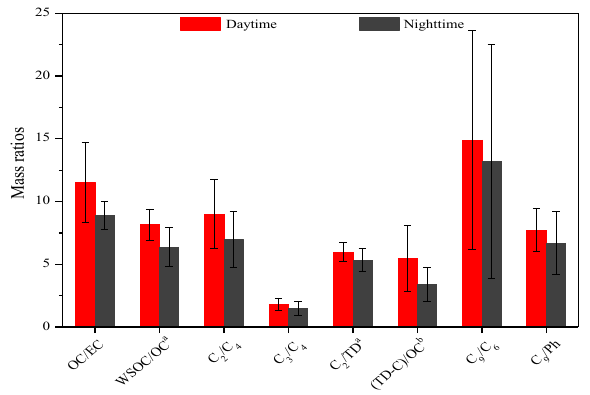
Figure 4. Diurnal variations of mass ratios of OC / EC, WSOC / OC, C 2 / C 4 , C 3 / C 4 , C 2 / TD, (TD-C) / OC, C 9 / C 6 and C 9 / Ph. (TD: total dicarboxylic acids; TD-C: the carbon concen- tration of total dicarboxylic acids. a The mass ratios expanding 10 times. b The mass ratios expanding 100